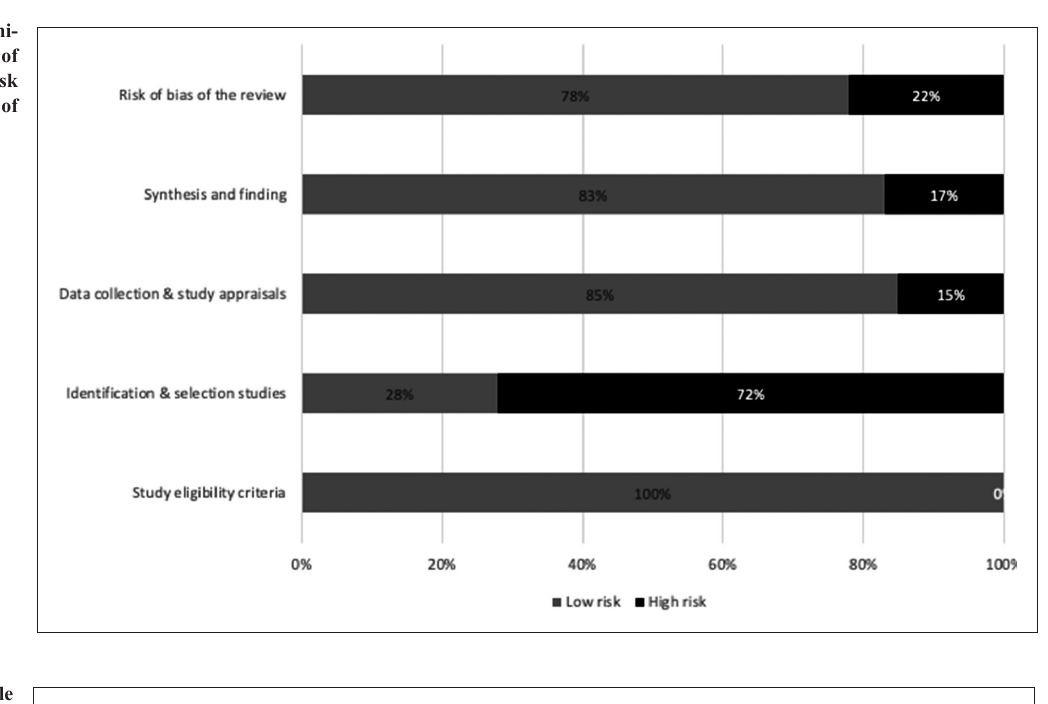
selection process for the current review.